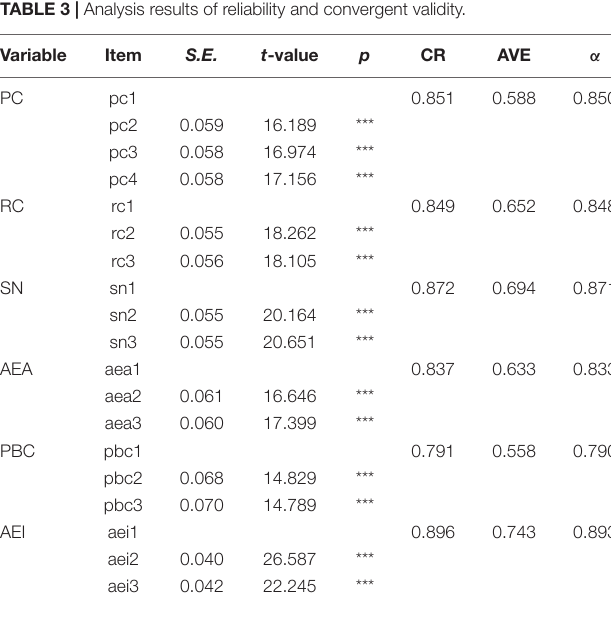
TABLE 2 | Construct validity. TABLE 3 | Analysis results of reliability and convergent